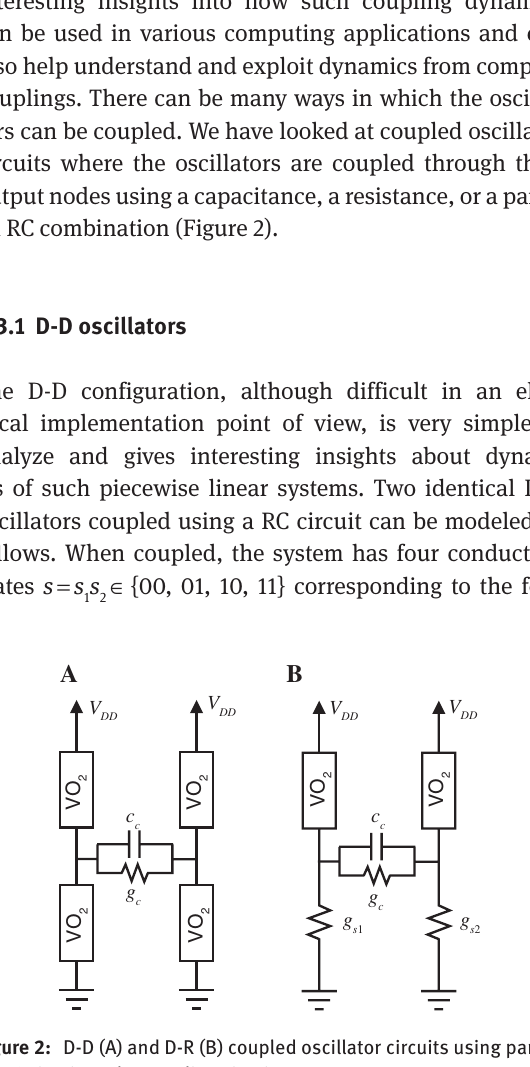
Figure 2: D-D (A) and D-R (B) coupled oscillator circuits using paral- lel RC circuit as the coupling